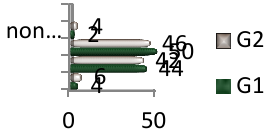
Figure 12: Comparison between diabetic and non-diabetic cases according to Causative fungi